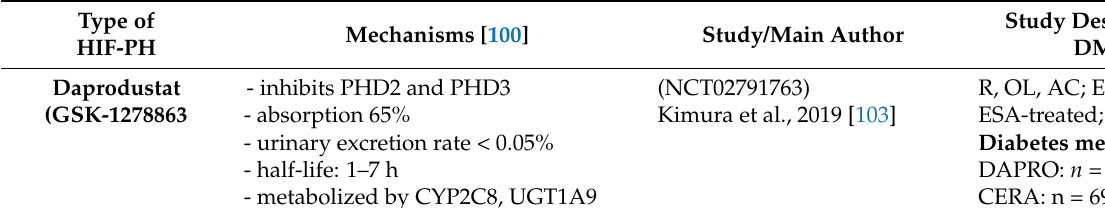
Table 1. Summary of the characteristics of each drug class and the mechanisms and relevant clinical studies of HIF-PHI in diabetic NDD-CKD patients (adapted with courtesy from V. Haase